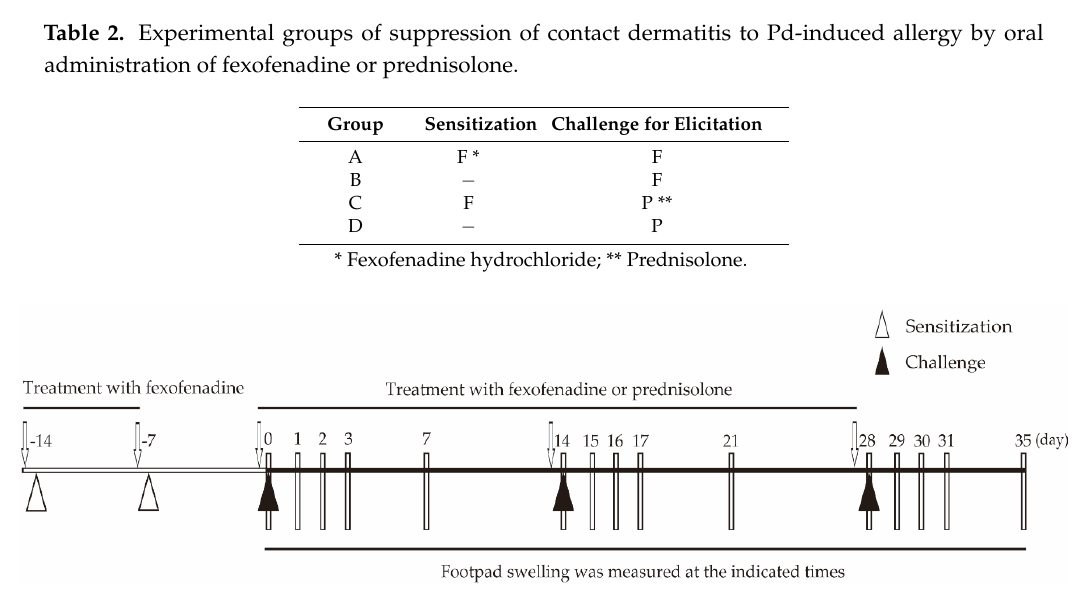
Figure 1. Schedule of the sensitization and elicitation of palladium (Pd)-induced allergic mice and oral administration of fexofenadine or prednisolone. The start of the first challenge was defined as day 0. Sensitization using palladium was performed every week throughout the experimental period from day –14 to day 0. The challenge for elicitation using Pd was performed every 2 weeks throughout the experimental period from day 0 to day 35. Arrows show when fexofenadine hydrochloride and prednisolone were orally administered at 10 mg/kg at 1 h before sensitization or challenge. Between challenges, the bar indicates the measurement day of left and right footpads. Footpad swelling was measured at 28, 29, 30, 31, and 35 days. All mice were sacrificed at day 35, and the footpads were taken as samples. Table 1. Experimental groups of contact dermatitis to Pd-induced allergy. BALB/cAJcl Sensitization